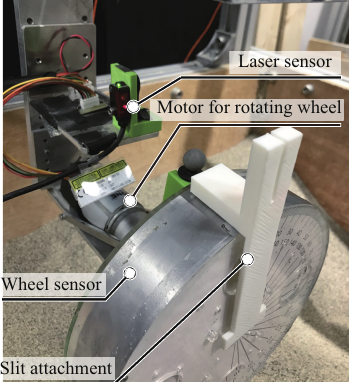
Figure 10. Schematic view of typical sensor position. The position θ e is the sensor position in the opposite direction to the towing, and θ o is the sensor position in the towing direction.